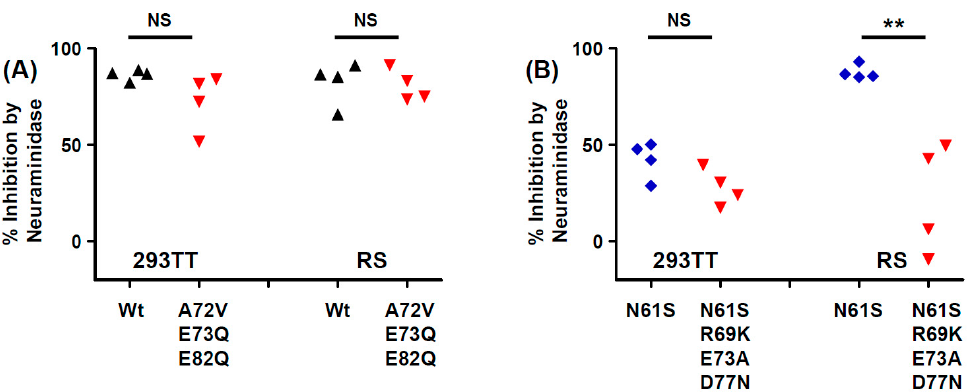
Figure 6. Sialic acid dependence of genotype I and genotype IV VP1 variants. Percentage inhibition of infectious entry of wild-type and V 72 Q 73 Q 82 genotype Ib2 PSV ( A ), and S 61 and S 61 K 69 A 73 N 77 genotype IVc2 PSV into 293TT and RS cells ( B ). One of three independent experiments is shown, with groups compared by two-tailed t-test. ** p < 0.01.